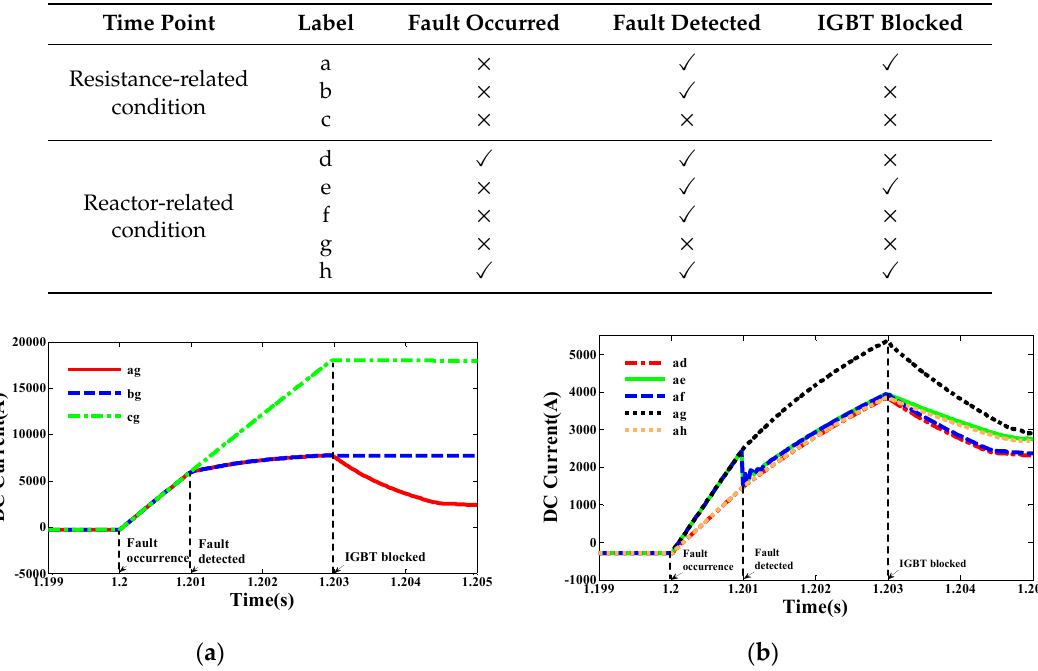
Figure 11. DC fault current characteristics ( a ) with variable limiting inductance; ( b ) with variable energy dissipation resistance.